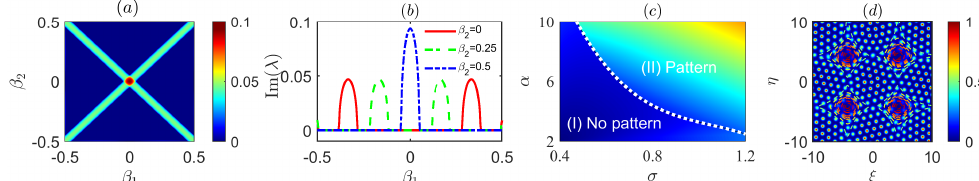
Figure 5. MI, phase diagram, and pattern formation with optical confining potential: ( a ) imaginary part of eigenvalues [i.e., Im( λ )] as functions of β 1 and β 2 ; ( b ) cross section of the eigenvalue spectrum as a function of β 1 for β 2 = 0 (red line), β 2 = 0.25 (green dotted line), and β 2 = 0.5 (blue dashed- dotted line), respectively; ( c ) phase diagram for patterns by varying σ and α ; ( d ) distribution of the stable pattern | u | / | u | max as functions of ξ and η with σ = 0.9, α = 10, and R ⊥ = 5.5 µ m; here, we also show the contours of optical confining potential with a dotted